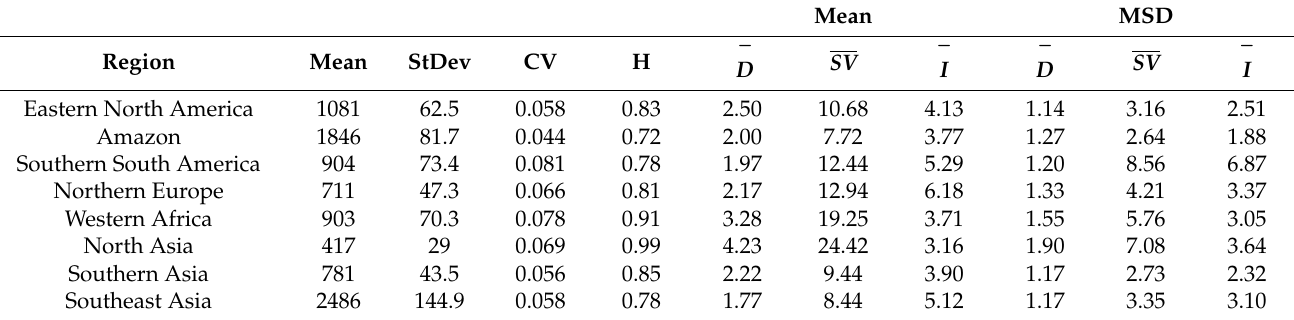
Table 4. Summary statistics and average crossing properties for areal average precipitation below the mean and MSD for the 8 regions for the period